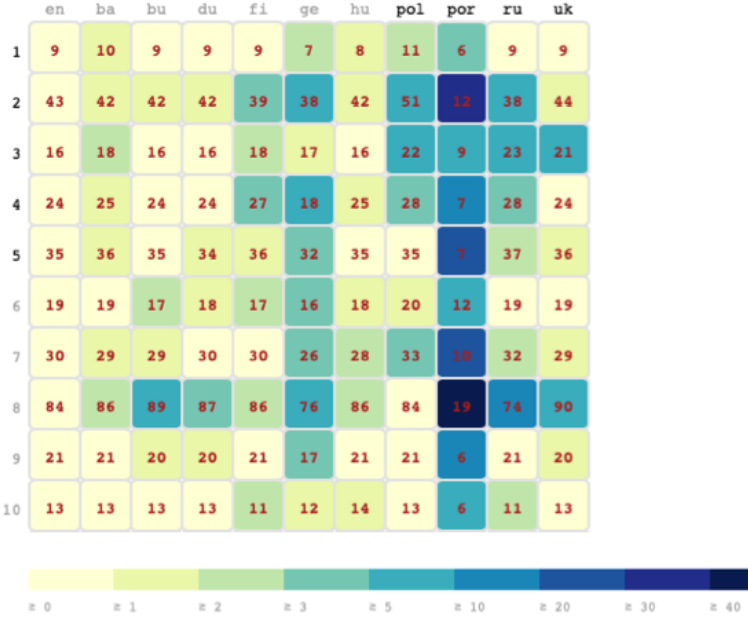
Figure 5. Paragraph counts from Chapter 1 to Chapter 10 in English, Basque, Bulgarian, Dutch, Finnish, German, Hungarian, Polish, Portuguese, Russian and Ukrainian of the novel Adventures of Huckleberry Finn . Heat map color varies with the difference of paragraph counts in the corresponding chapter.